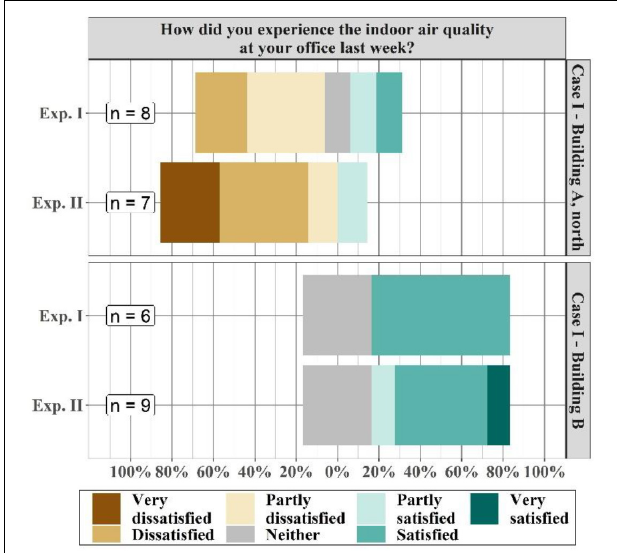
FIGURE 10 | Divergent bar plots of responses for the last week in Exp. I and II in case I regarding satisfaction with IAQ.